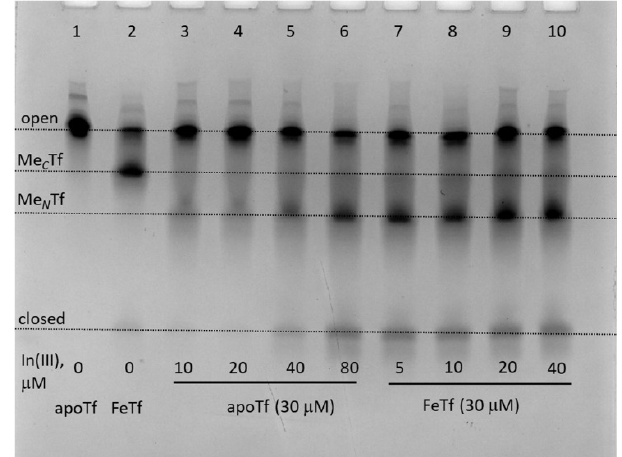
Figure 4. Urea-PAGE of the mixtures containing 30 μM of apoTf or FeTf and varied concentrations of In(III)-NTA (see Materials and Methods for details) in the binding buffer (20 mM HEPES, 25 mM NaHCO 3 , 140 mM NaCl, pH 7.4) [3] reacted for 24 h at 310 K. All samples were diluted to ~5 μM Tf with the before loading into the gel. Four main Tf conformations (Figure 1) are marked (M C Tf and M N Tf contain one metal ion bound to C -lobes or N -lobes, respectively).